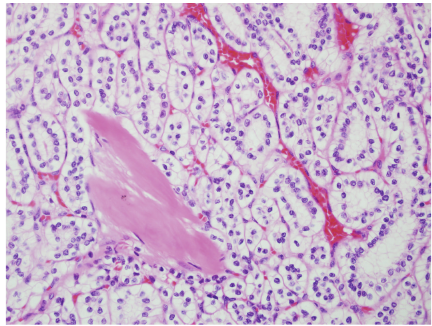
Figure 3: High power showing characteristic subnuclear clearing and low nuclear grade, with smooth muscle bundles in between (lower left corner).